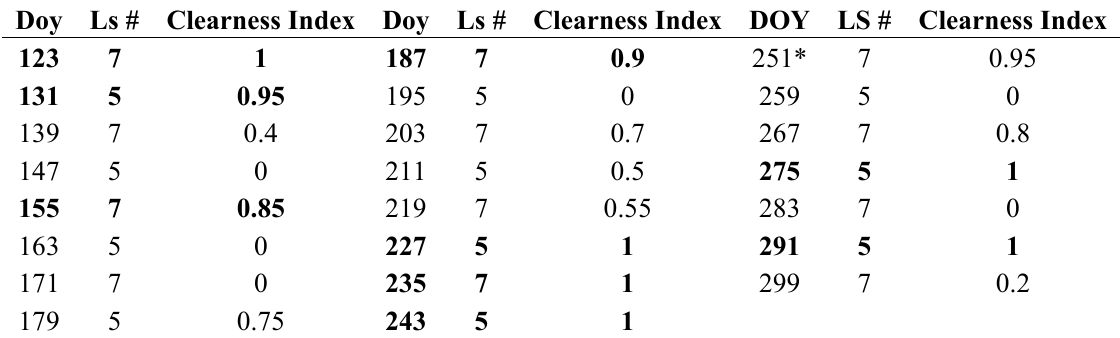
Table 1. Image dates (year 2011) with clearness index and Landsat satellite from which the image was taken. Bolded entries indicate images that have an index greater than 0.8 and that were used in